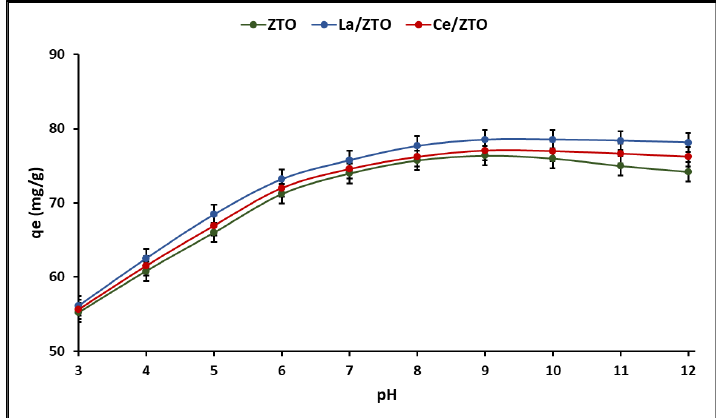
Figure 5. Cyanide adsorption capacity as a function of the pH of the solution.